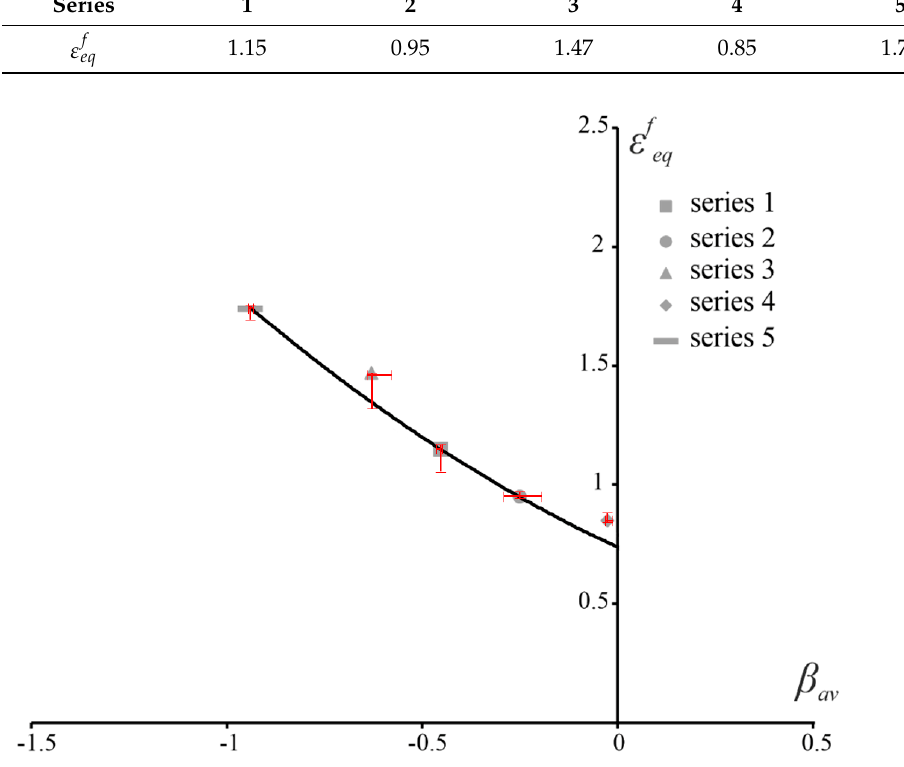
Figure 6. Workability diagram for C45E steel. Table 4. Coefficients A and B involved in Equation (9).